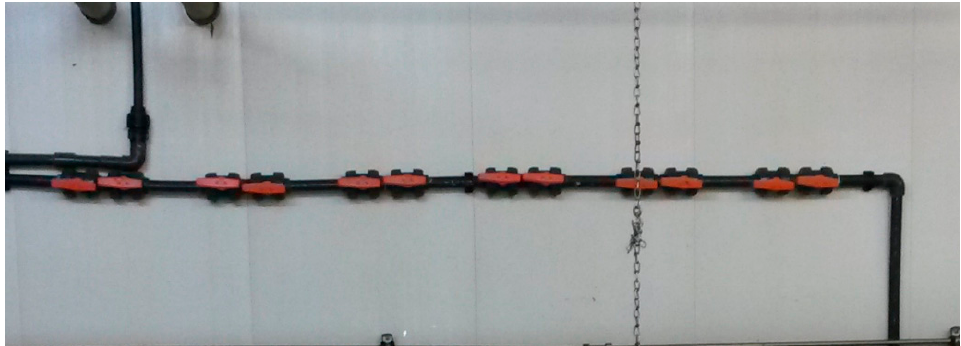
Figure 1. Sampling points and doser position at samplings 1 to 8 ( a ) and samplings 9 to 14 ( b ).